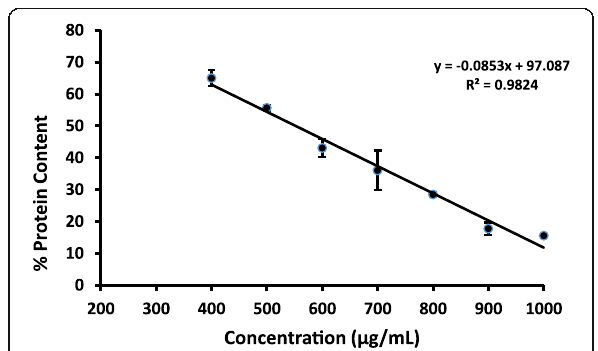
Fig. 4 Percentage protein content (Mean ± SD; n = 3) of cell lysate to that of the untreated cells after 24 hour exposure of Semecarpus parvifolia Thw. leaves